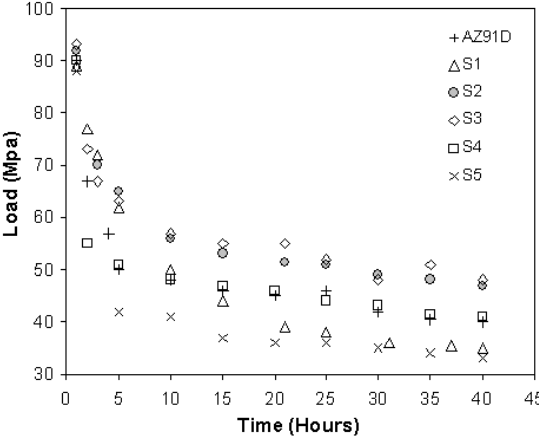
Figure 2. Stress versus time for a period of up to 40 h from the onset of the